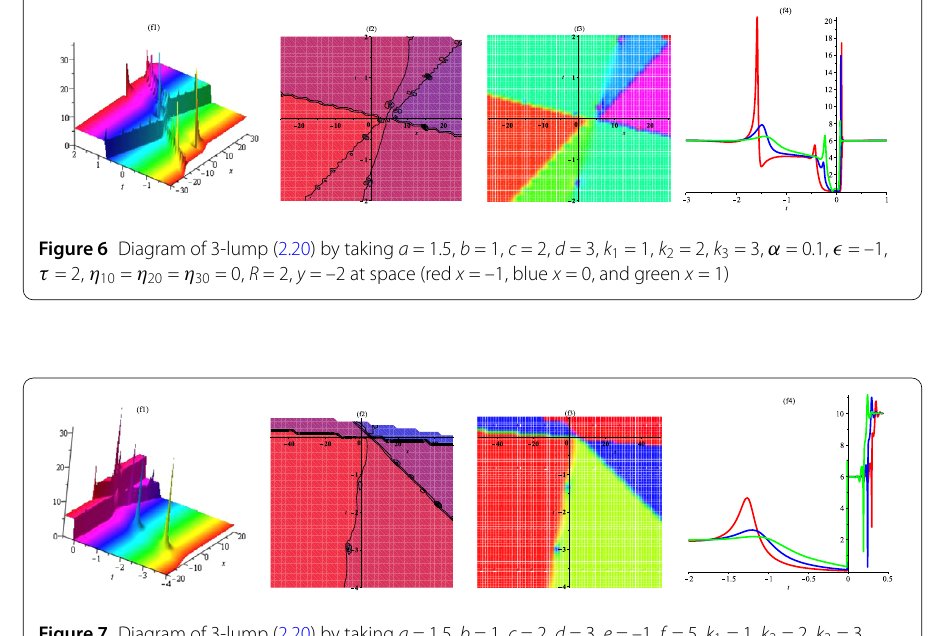
Figure 7 Diagram of 3-lump (2.20) by taking a = 1.5, b = 1, c = 2, d = 3, e = –1, f = 5, k 1 = 1, k 2 = 2, k 3 = 3, α = 0.1, (cid:14) = –1, τ = 2, η 10 = η 20 = η 30 = 0, R = 2, y = –2 at space (red x = –1, blue x = 0, and green x =